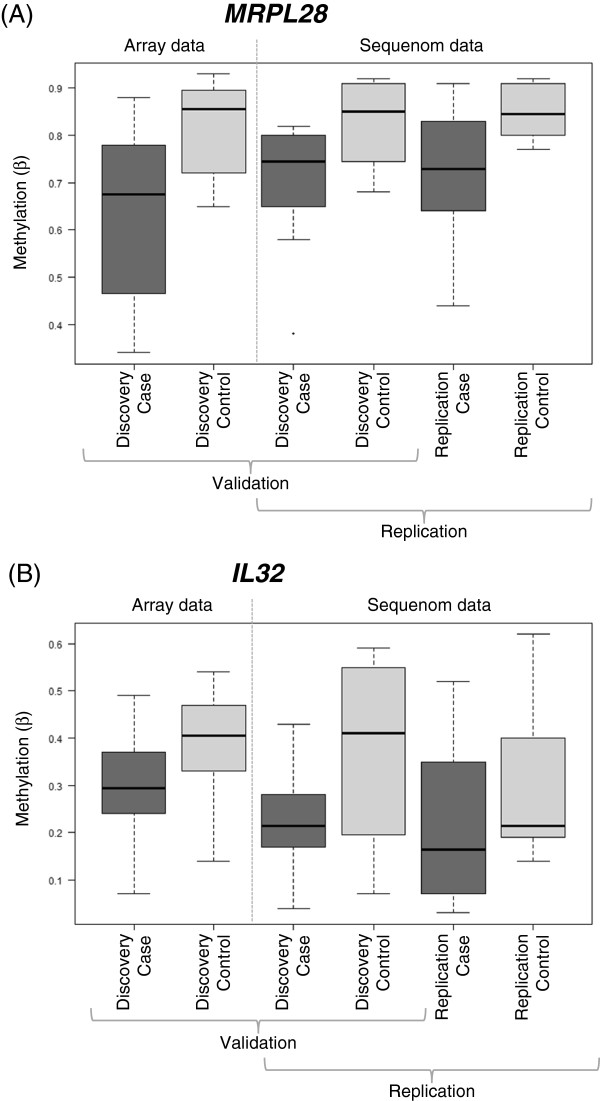
Boxplots of validation and replication JIA case-control data for differentially methylated genes MRPL28 and IL32. (A) HM27 MRPL28 array data (probe cg12437481) for the discovery case-control pairs, and MRPL28 sequenom data (assay unit CpG_14.15 – see Additional file
1: Figure S3) for the discovery and replication case-control pairs. (B) HM27 IL32 array data (probe cg18350391) for the discovery case-control pairs, and IL32 sequenom data (assay unit CpG_10 – see Additional File 1: Figure S4) for the discovery and replication case-control pairs. Comparing array and sequenom data for the discovery samples demonstrates validation of array data, and comparing sequenom data between the discovery and replication samples demonstrates replication of the direction of effect and magnitude of difference between the cases and controls at these loci